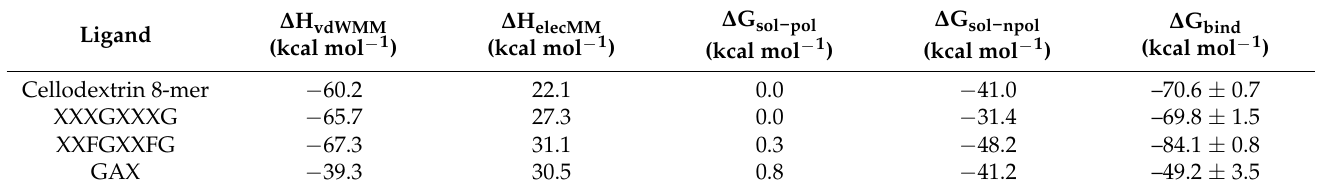
Table 4. MM-GBSA analysis for the interaction of FcEXPA1, FcEXPA2, and FcEXPA5 with cellulose and XXFGXXFG as the